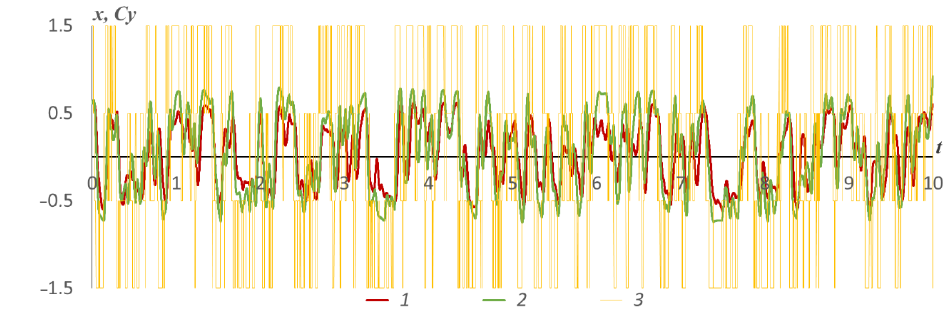
1 2 ; 2—the system state, controlled by u ∗ t t i